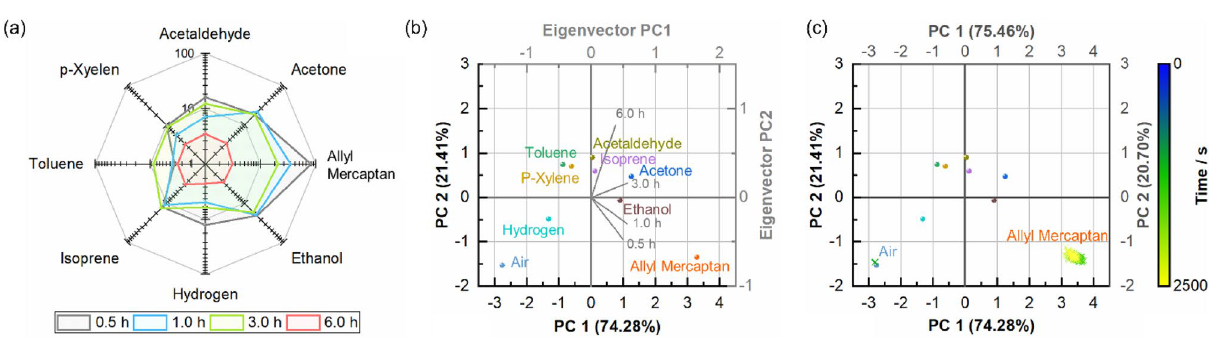
Figure 4. ( a ) Electrical resistance variations under air flow. ( b ) Sensor signal response for 54 ppm allyl mercaptan gas. ( c ) Electrical resistance variation at 300 °C for 11-ppm allyl mercaptan. (Line is the mean value, with less than 1% change in the range.).